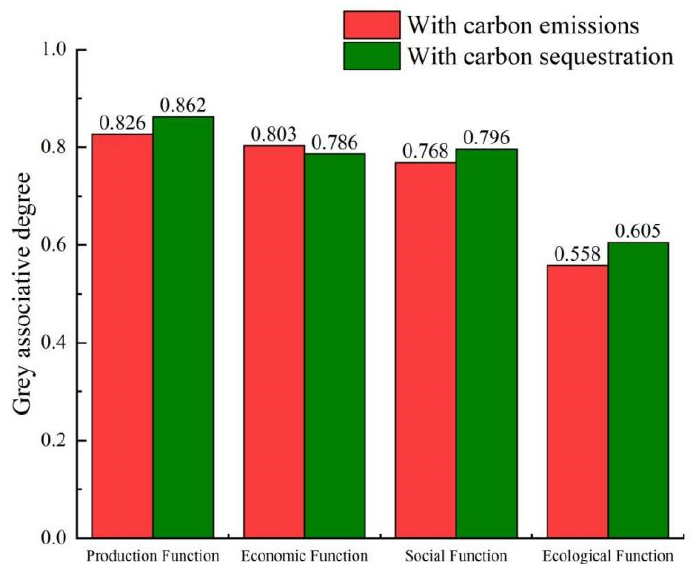
Figure 9. Grey associative degree between agricultural multifunctionality and carbon emissions as well as carbon well as carbon sequestration.